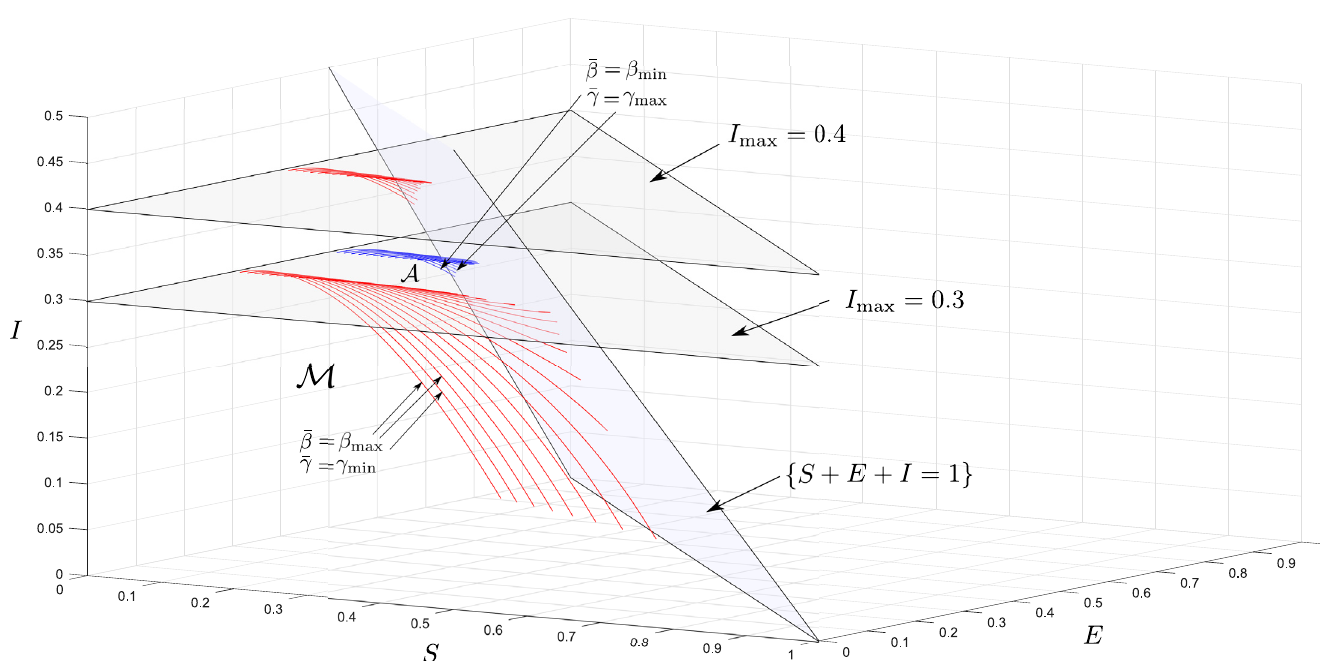
Fig 4. Sets for perfect SEIR model, with I max 2 {0.3, 0.4}. Shown are curves running along the barriers of the MRPI (in red) and the admissible set (in blue).